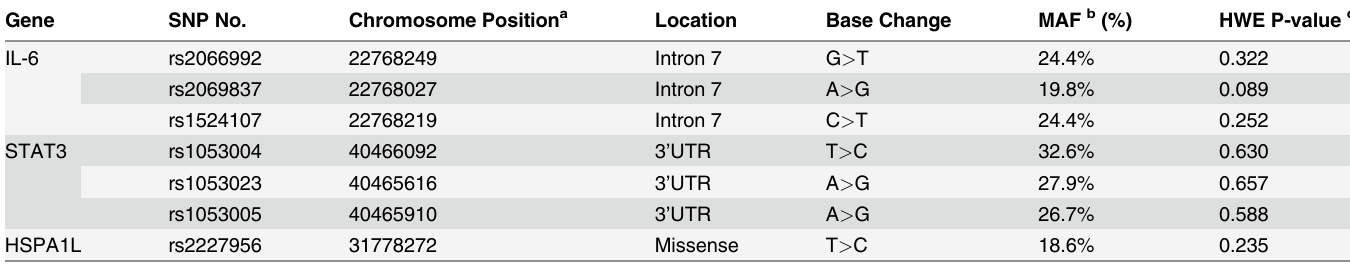
Table 1. Information of seven selected SNPs. Gene SNP No.